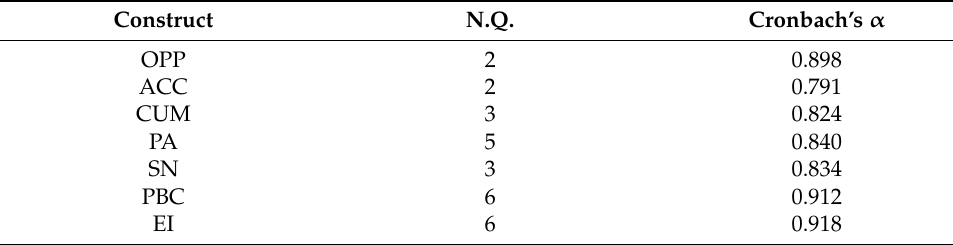
Table 2. Reliability analysis results.